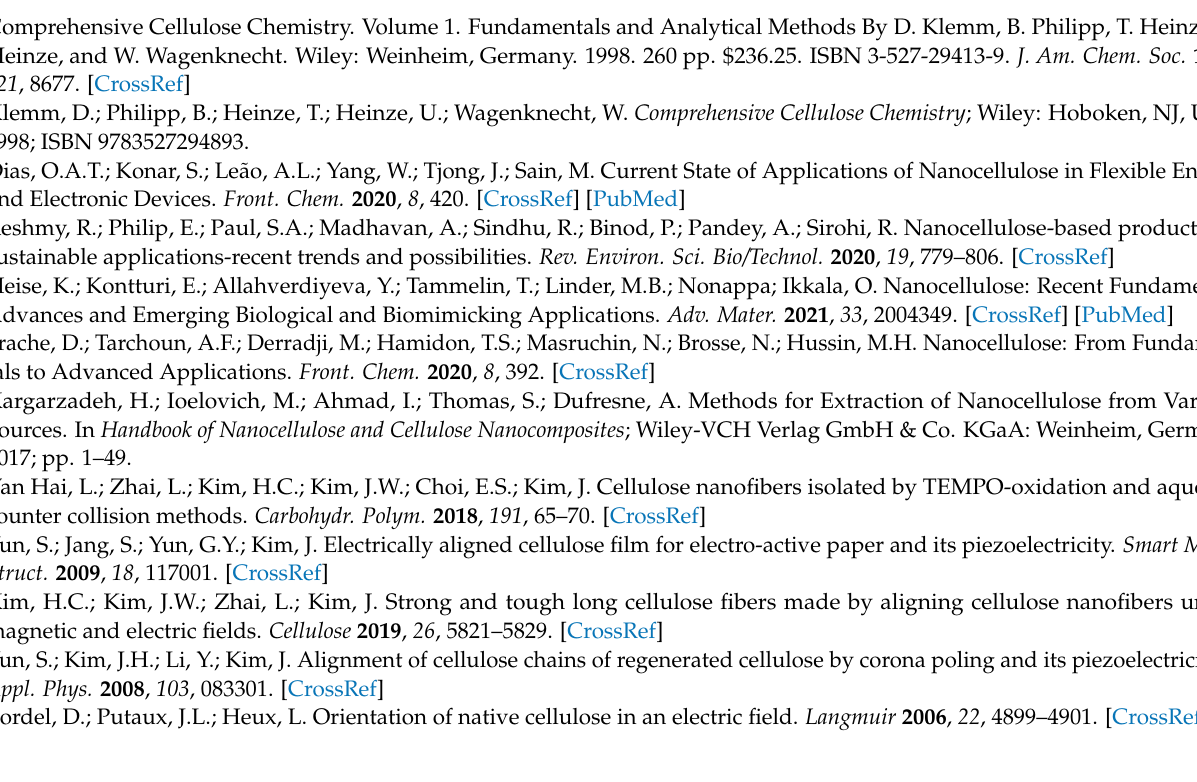
nanofiber alignment under electric field (DOC). Table S1. Snapshots of CNF alignment along the applied external electric field (z-axis) for replica MD (0.06mV/nm_1 and 0.06mV/nm_2). Table S2. Electric field along z-axis: Root-Mean-Square displacement (RMSD), the radius of gyration (R g ), and end-to-end length, averaged over 10 ns of simulation time. Table S3. Averages of reproducible hydrogen bonds, the radius of gyration, end-to-end length at the 0.06mV/nm electric field with repeat productions (0.06mV/nm_1: the first MD production 0.06mV/nm_2: the second MD production). Table S4. Electric field along the x-axis: RMSD, the radius of gyration (R g ), end-to-end length, and hydrogen bonds population. Figure S1. Electric field along z-axis: Time evolution of (a) Root Mean Square Deviation (RMSD) (b) Radius of gyration (c) End-to-end length (d) Intersheet hydrogen bonds. Figure S2. Reproducible Hydrogen bonds, the radius of gyration, end-to-end length for replica MD (0.06mV/nm_1 and 0.06mV/nm_2). Figure S3. Reproducible Hydrogen bonds for replica MD (0.06mV/nm_1 and 0.06mV/nm_2): Intra H-bond O3H3 . . . ..O5 (a) Intra H-bond O2H2 . . . ..O6’ (b) Inter H-bond O6H6 . . . ..O3 (c) Inter H-bond O6H6 . . . ..O2 (d). Figure S4. Hydrogen bond formation distance between donor and acceptor atoms of cellulose and their occupancy under the external electric field for replica MD (0.06mV/nm_1 and 0.06mV/nm_2). Figure S5. Electric field along with the x-axis (a) RMSD, (b) Radius of gyration, (c) End-to-end length, and (d) Donor acceptor distance and occupancy of hydrogen